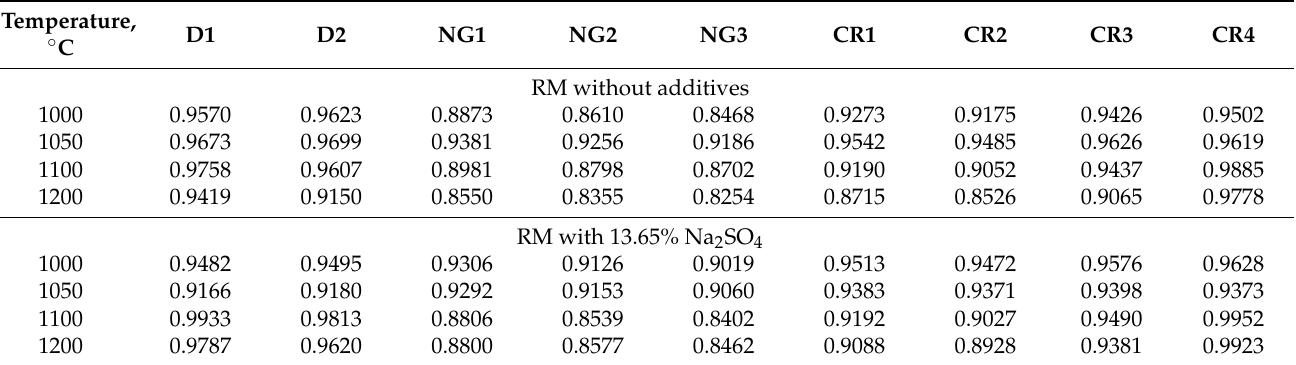
Table 3. Correlation coefficients for different kinetics models of the iron oxide reduction from RM with the Na 2 SO 4 additive and without.